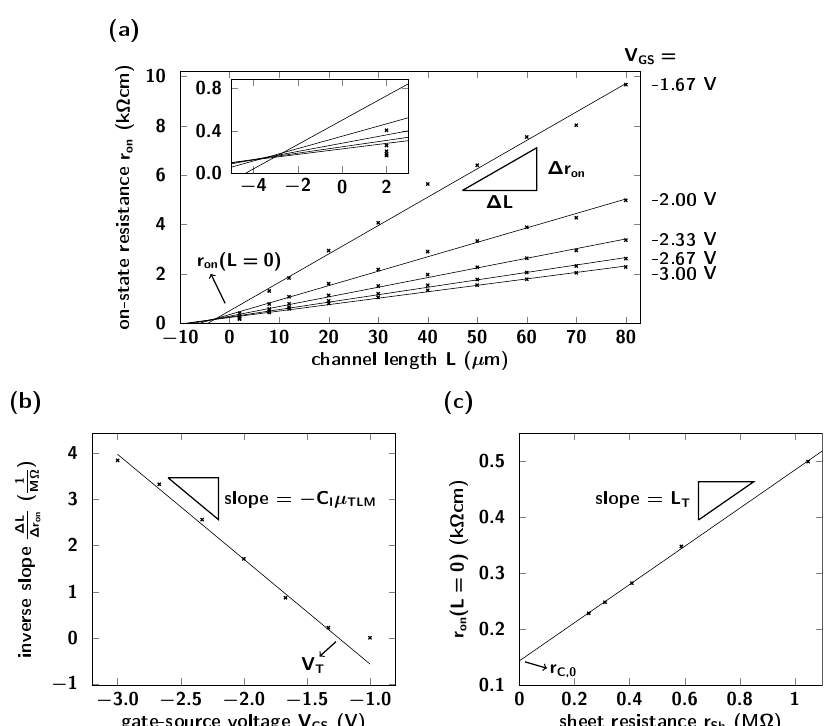
Figure 2. Parameter extraction in the framework of the conventional transmission line method (TLM), performed here on a set of bottom-gate, bottom-contact p-channel TFTs based on the small-molecule semiconductor DNTT. In ( a ), the on-state resistance r on = W ∂ V DS / ∂ I D for V DS → 0 V, extracted from the measured output characteristics, is plotted as a function of the channel length for different gate-source voltages V GS . From a linear fit to the data, the inverse slope ∆ L / ∆ r on and the y-axis intersect r on ( L = 0 ) are extracted. The inset shows a magnification of the region in which the linear fits intersect and the extracted r on values for the smallest channel length of L = 2 µ m (symbols). In ( b ), ∆ L / ∆ r on is plotted as a function of the gate-source voltage V GS , and from the linear fit to the data, the threshold voltage V T = 1.25 V and the intrinsic channel mobility µ TLM = 3.2 cm 2 /Vs are obtained. In ( c ), r on ( L = 0 ) = r Sh L T + r C ,0 is plotted as a function of the sheet resistance r Sh = | V 0 | [ V 0 C I µ TLM ( V GS − V T )] − 1 , and from the linear fit to the data, the transfer length L T = 3.4 µ